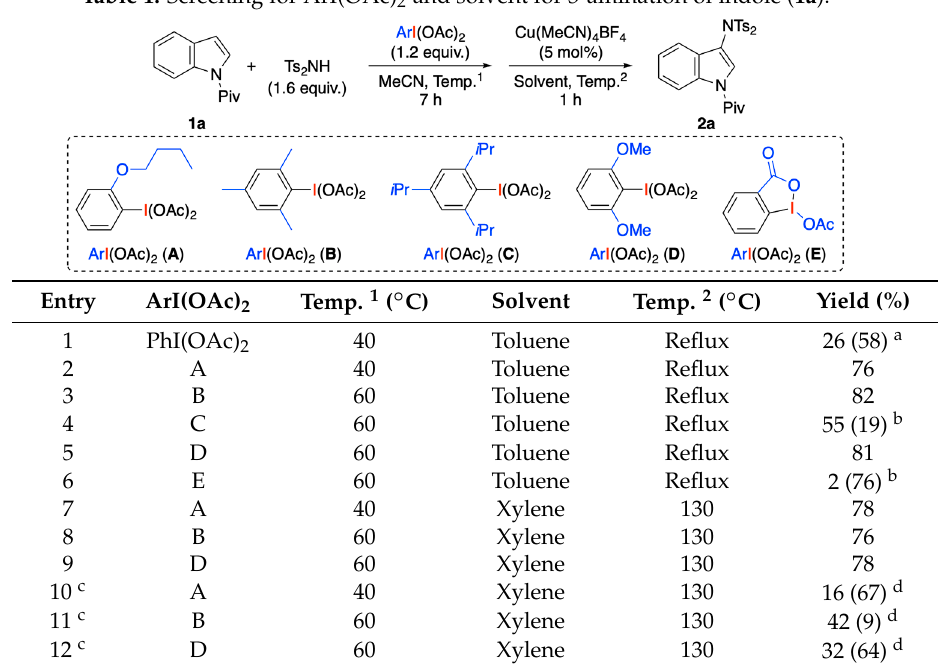
Table 1. Screening for ArI(OAc) 2 and solvent for 3-amination of indole ( 1a